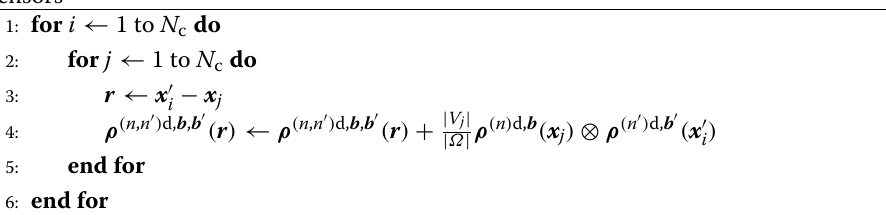
Algorithm 1 Calculation of discrete homogenized pair density tensors using single-point tensors